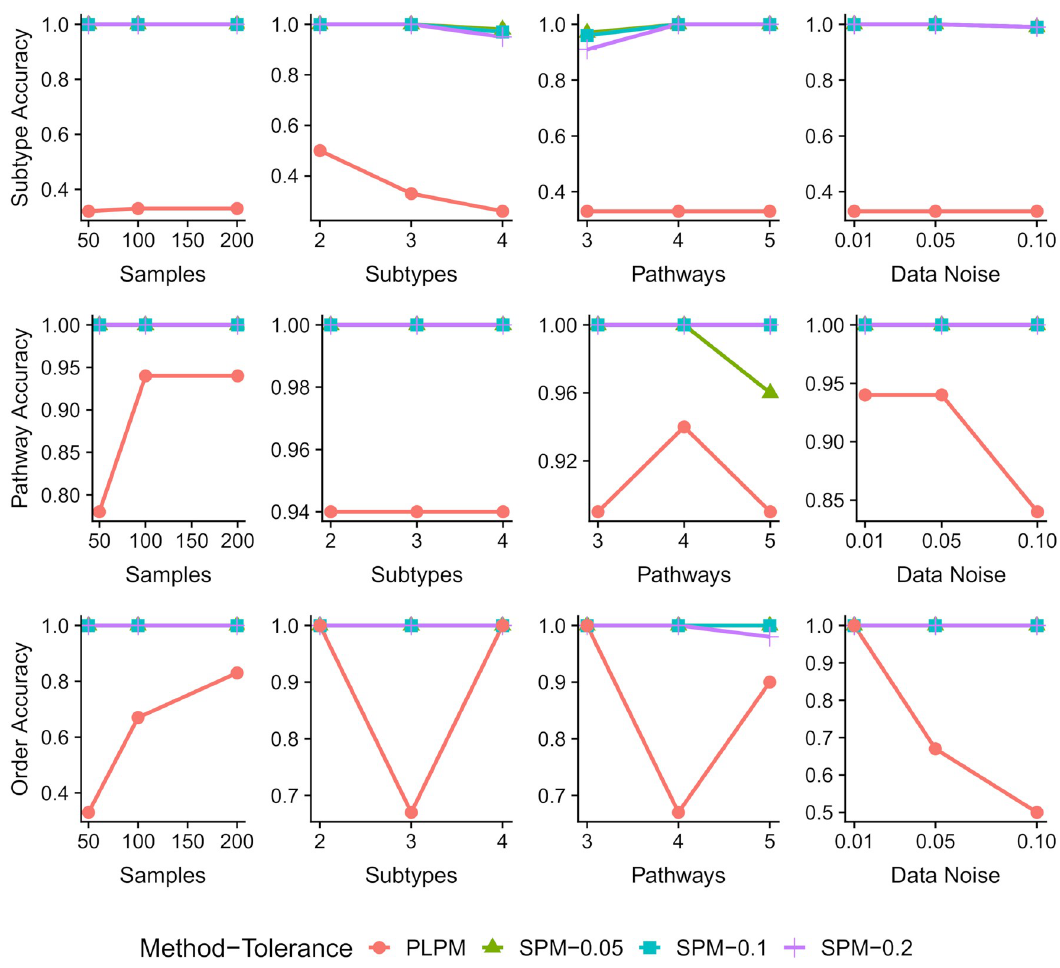
Fig 2. Results of sensitivity analysis using synthetic data. Note that each graphs might have different scales for the vertical axes.